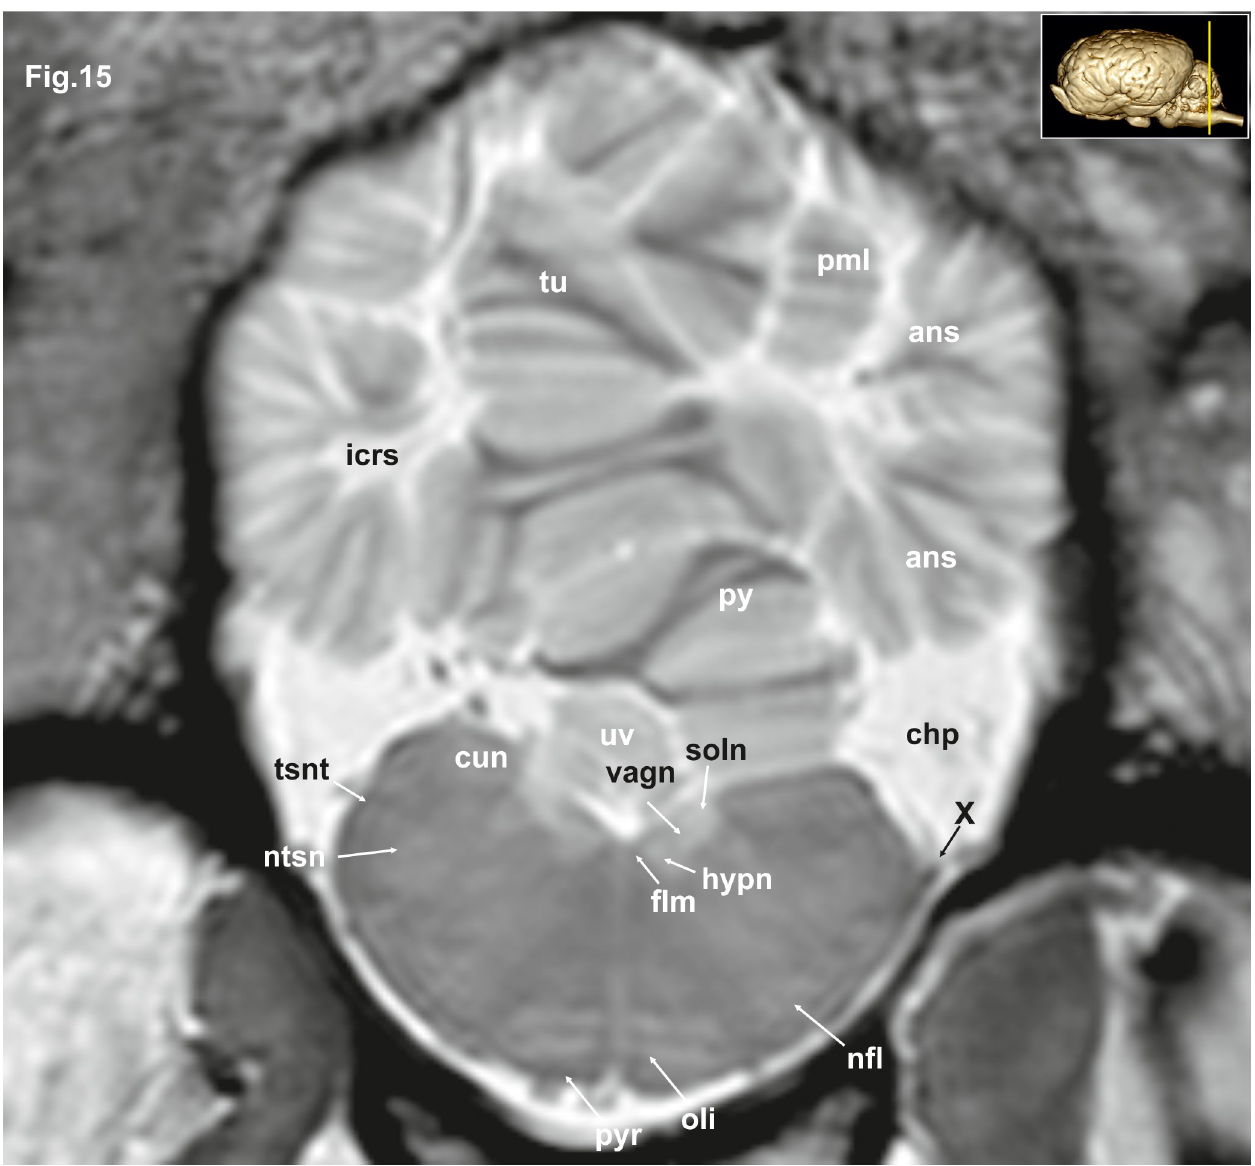
Fig 15. Transverse magnetic resonance image of the equine brain on the level of the cuneate nuclei. ans: ansiform lobule, chp: choroid plexus; cun: cuneate nucleus, flm: medial longitudinal fasciculus, hypn: nucleus of the hypoglossal nerve, icrs: intercrural sulcus, nfl: nucleus of the lateral fascicle, ntsn: nucleus of the spinal tract of the trigeminal nerve, oli: olivary nucleus, pml: paramedian lobule, py: pyramis of the vermis, pyr: pyramidal tract, tsnt: spinal tract of the trigeminal nerve, tu: tuber of the vermis, uv: uvula of the vermis, vagn: nucleus of the vagus nerve, X: vagus nerve. https://doi.org/10.1371/journal.pone.0213814.g015 S2–S8 Figs: cn) as the dorso-medial component bulges into the central part of the lateral ven- tricle. It is isointense to the cerebral cortex. The lentiform nucleus comprises two parts, the putamen (Figs 3–7, 20–22 and 32; S2–S6 Figs: put), lying ventro-laterally and being associated with the globus pallidus (Figs 5, 6, 21, 30 and 31; S4 and S5 Figs: gp), separated from each other by a thin sheet of white matter. In the horse, the head of the caudate nucleus quickly tapers into the tail (cauda) and the body (corpus) is really short compared to other ungulates [17].